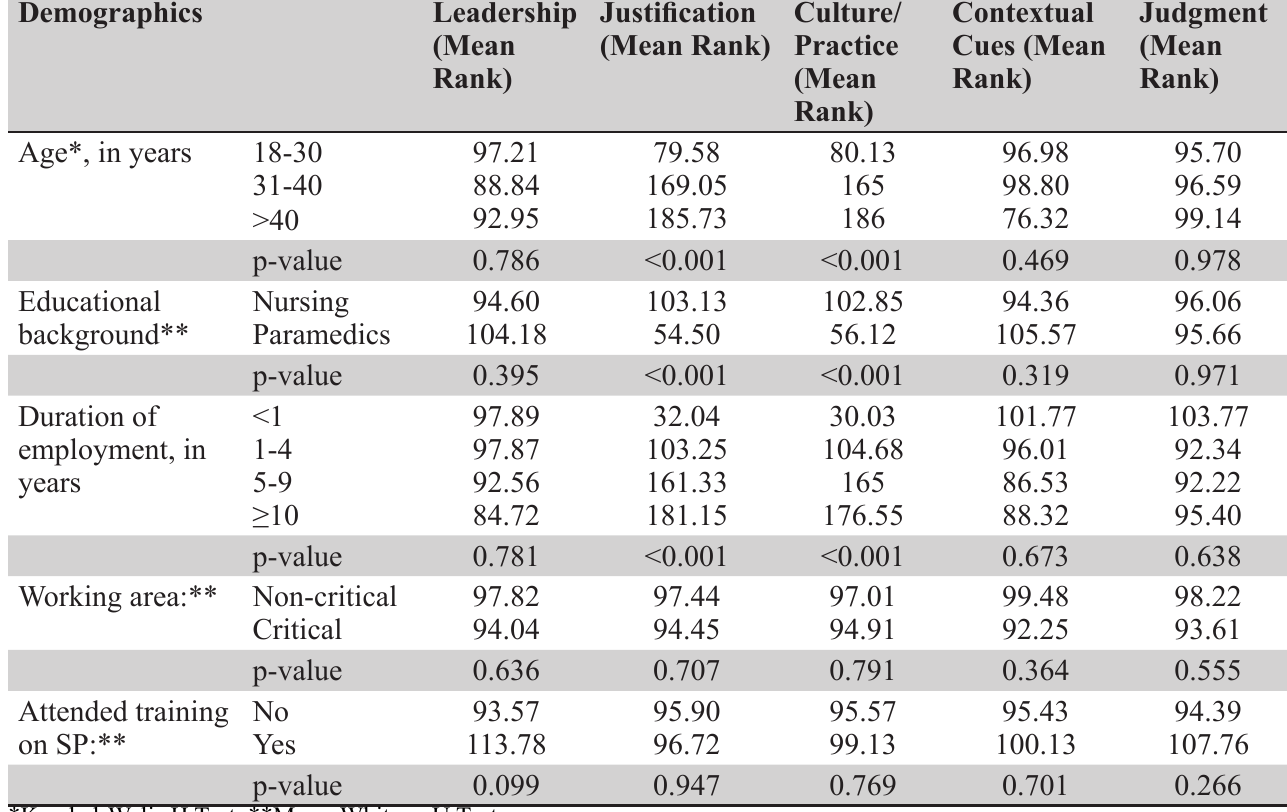
Table 3: Association between selected variables and factors influencing adherence to standard precautions (N=191)